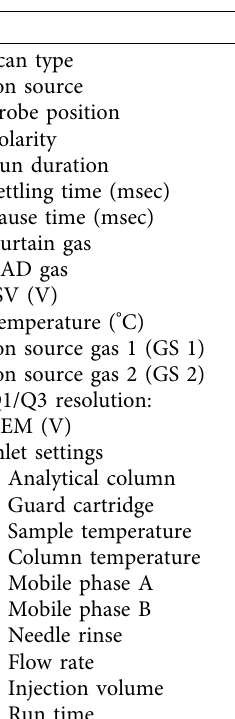
Table 1: LC-MS/MS conditions for the three assays on a single oral fuid sample.